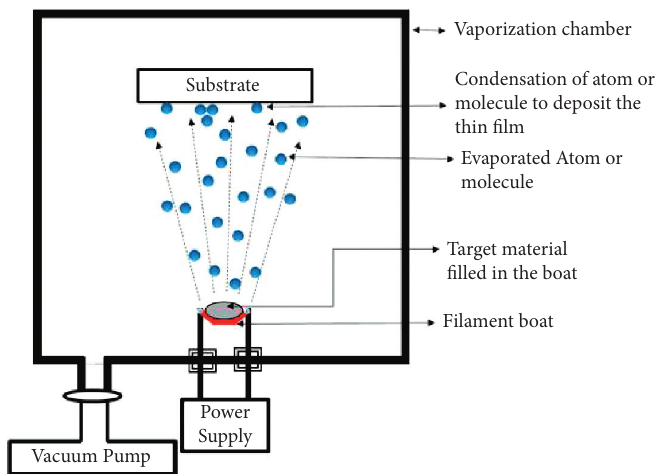
Figure 2: Schematic diagram of physical vapour deposition process.